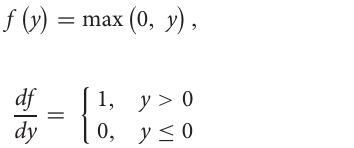
GSDs have a near-linear LTP curve ( β LTP of ∼ 1.60) and a non- linear LTD curve ( β LTD of ∼ 8.03). The normalized conductance responses as a parameter of the non-linearity factor are described in Supplementary Figure S1